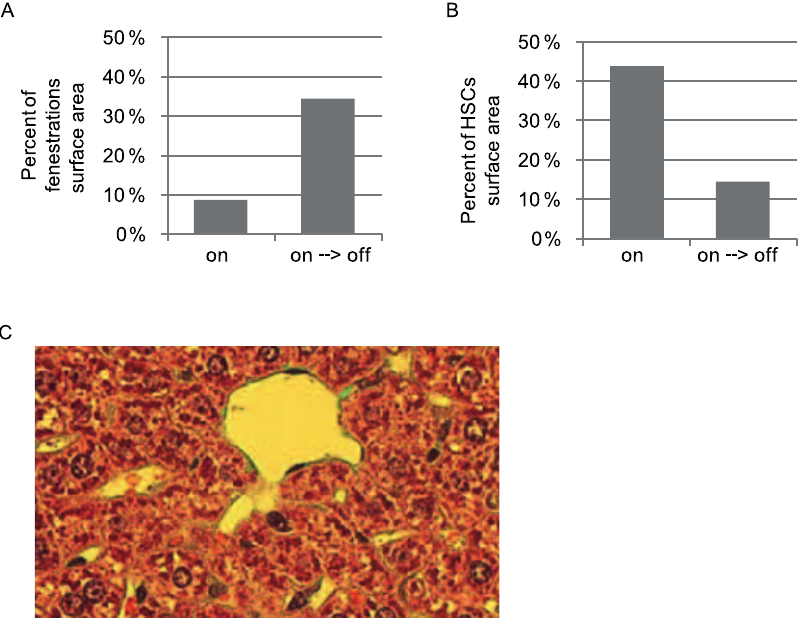
Figure 6. Liver phenotype is reversible upon relieving sVEGF-R1. One week after sVEGF-R1 shut off (on R off) (a) Quantification of the percent of fenestrations’ surface area in the sinusoids. ‘on’ 2 8.5%, ‘on R off’ 2 34.4% (b)-quantification of area covered by HSCs ‘on’ 2 43.7%, ‘on R off’ (‘on’ for one month then ‘off’ for one week) 2 14.4% (c) Goldner staining highlighting collagen fibers in green showing reduced extracellular-matrix deposition perisinusoidally compared to ‘on’ (fig 3E).